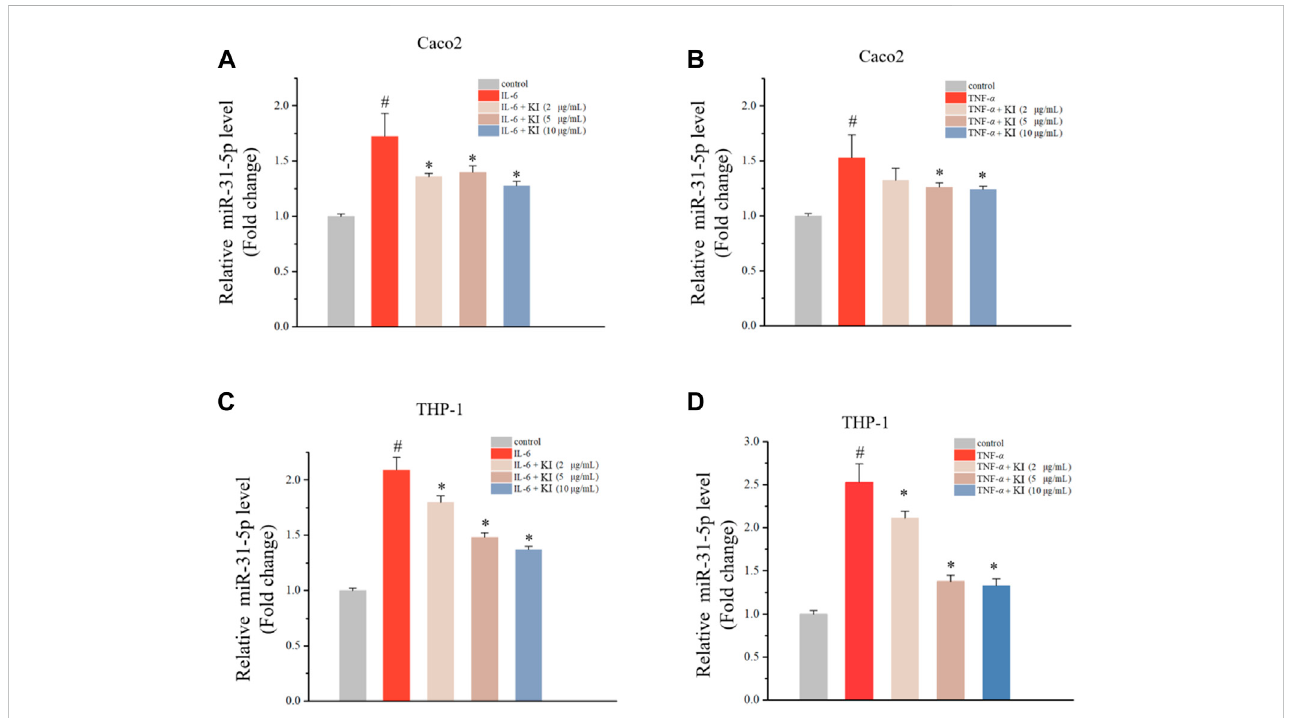
FIGURE 1 Levels of miR-31-5p in Caco2 and THP-1 cells treated with IL-6 or TNF- α . (A – B) RT-qPCR results of miR-31-5p in Caco2 cells stimulated by IL-6 (A) or TNF- α (B) for48 h (C – D) RT-qPCRresultsofmiR-31-5pinTHP-1cellsstimulatedbyIL-6 (A) orTNF- α (B) for48 h.Valuesaremeans±SDfromthreeseparate experiments. # p < 0.05 compared with the control group; * p < 0.05 compared with the IL-6 (A) and (C) or TNF- α (B) and (D)